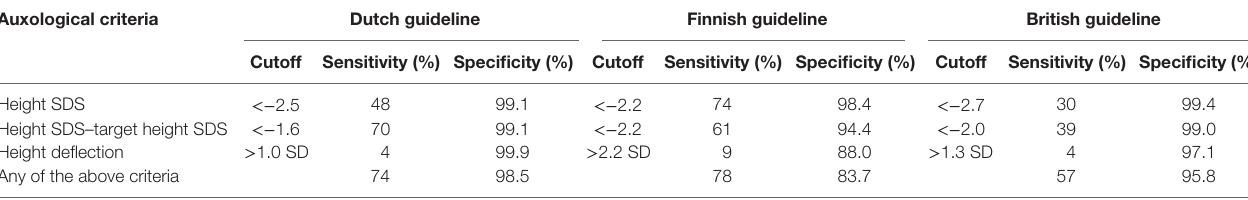
table 1 | Comparison of country-specific guidelines for referral of short children for diagnostic work-up. auxological criteria Dutch